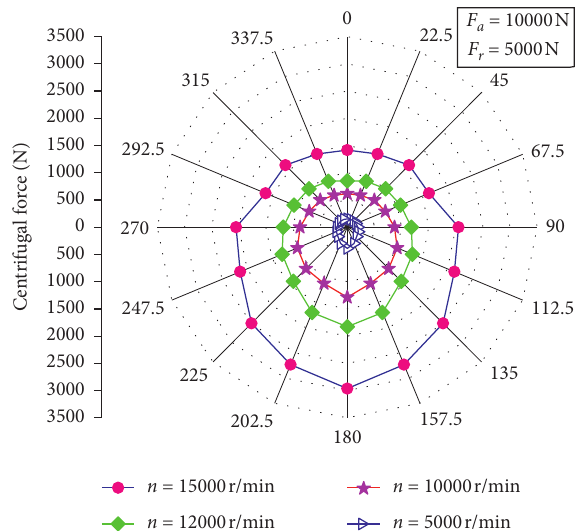
Figure 21: The variation of centrifugal force with different posi- tions of rolling elements at different rotational speeds.